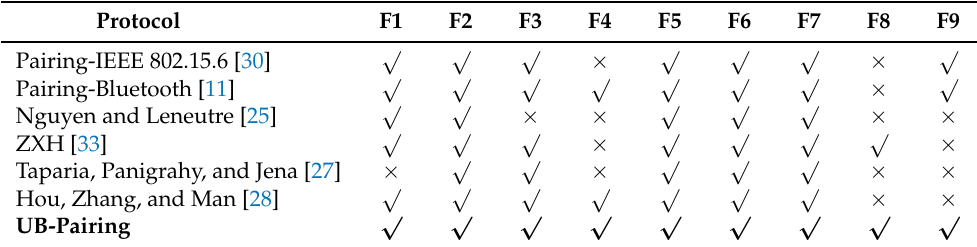
Table 3. Security and functionality comparison of UB-Paring and benchmark protocols.